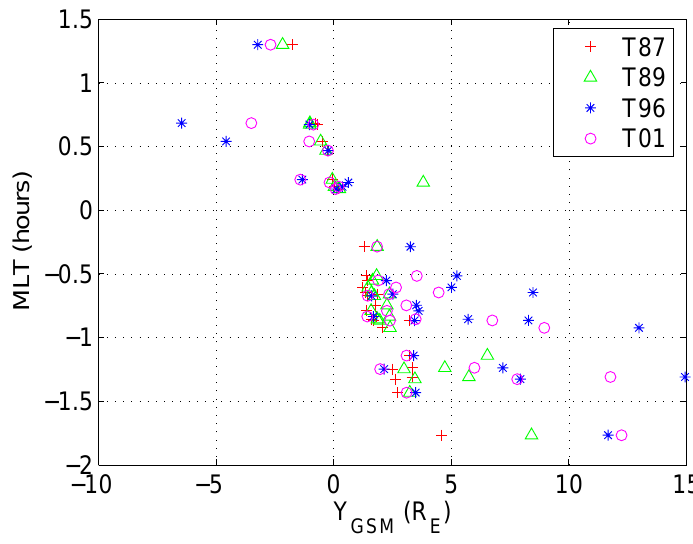
Fig. 6. Onset location for the dawn-dusk coordinate (Y) against magnetic local time.